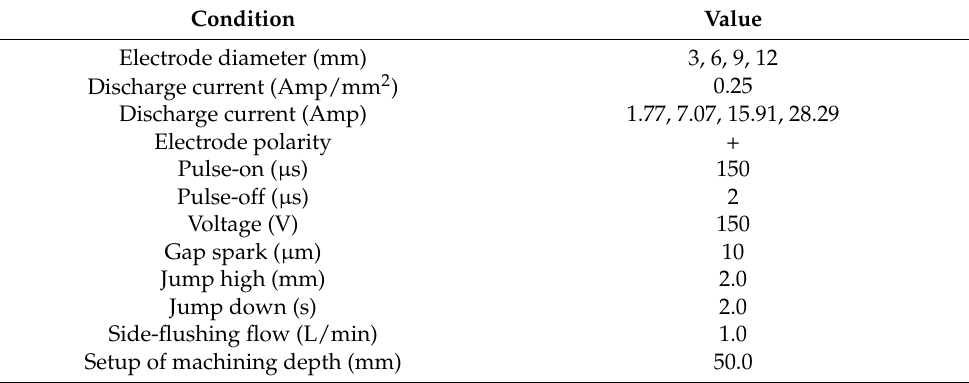
Table 3. Experimental